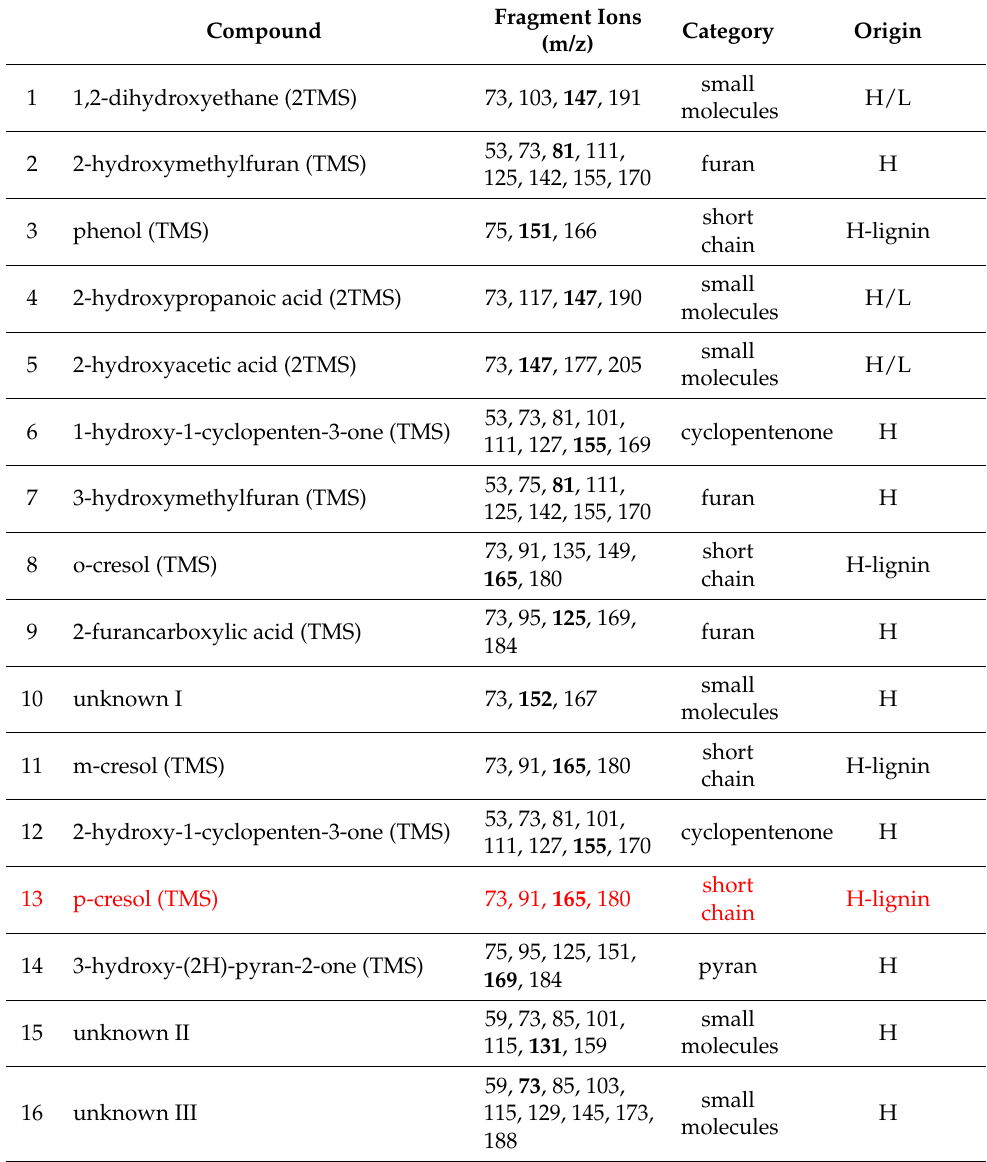
Table 2. Pyrolysis products identified by Py-GC/MS. Fragment ions’ mass-over-charge ratios (m/z) are also shown, where the m/z in bold indicates the main ion. Compounds were categorized, where H—holocellulose, L—lignin, lignin units: p-hydroxyphenyl (H-lignin), guaiacyl (G-lignin) and syringyl (S-lignin). Lignin pyrolysis products in red script were identified in lignin preparations (P1000, FB01). These were either very low or absent in archaeological pine and were used to evaluate lignin penetration in test specimens. Fragment Ions Category Compound (m/z)